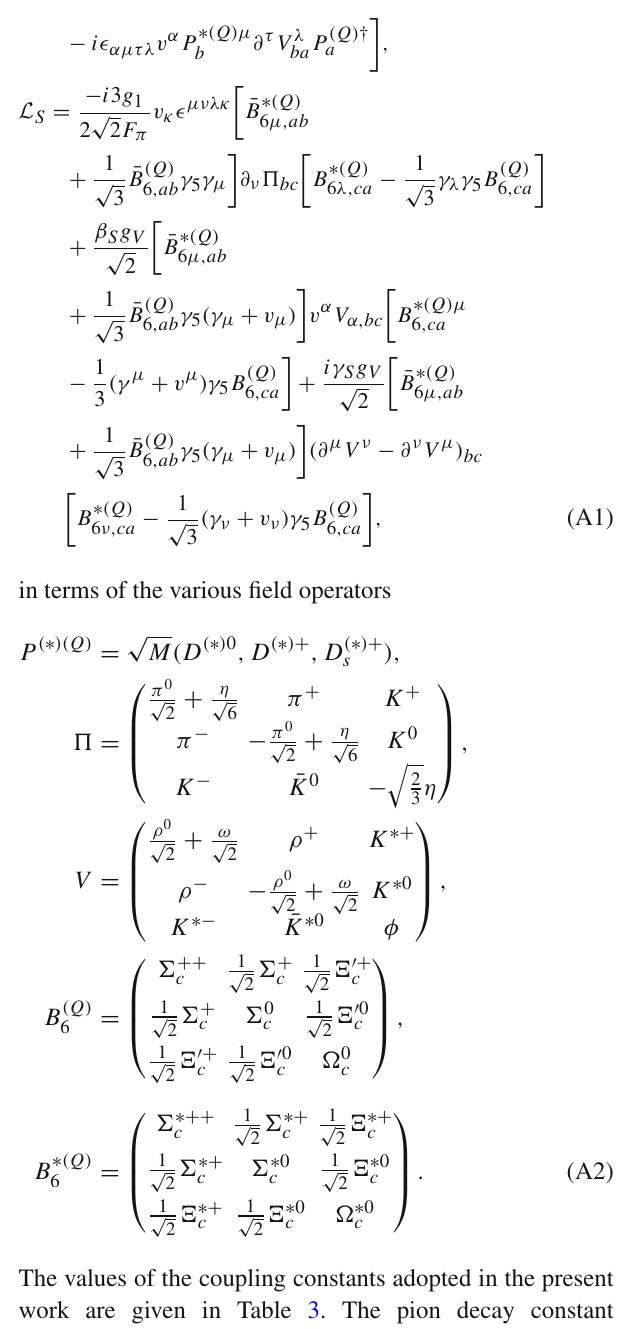
withthebaryon-firstconventionisapplied. (cid:5) j 1 m 1 j 2 m 2 | j 3 m 3 (cid:6) represents the Clebsch-Gordan coefficient ( m 1 m 2 m 3 | j 1 j 2 j 3 ) related to the composition j 1 + j 2 = j 3 . All the isospin